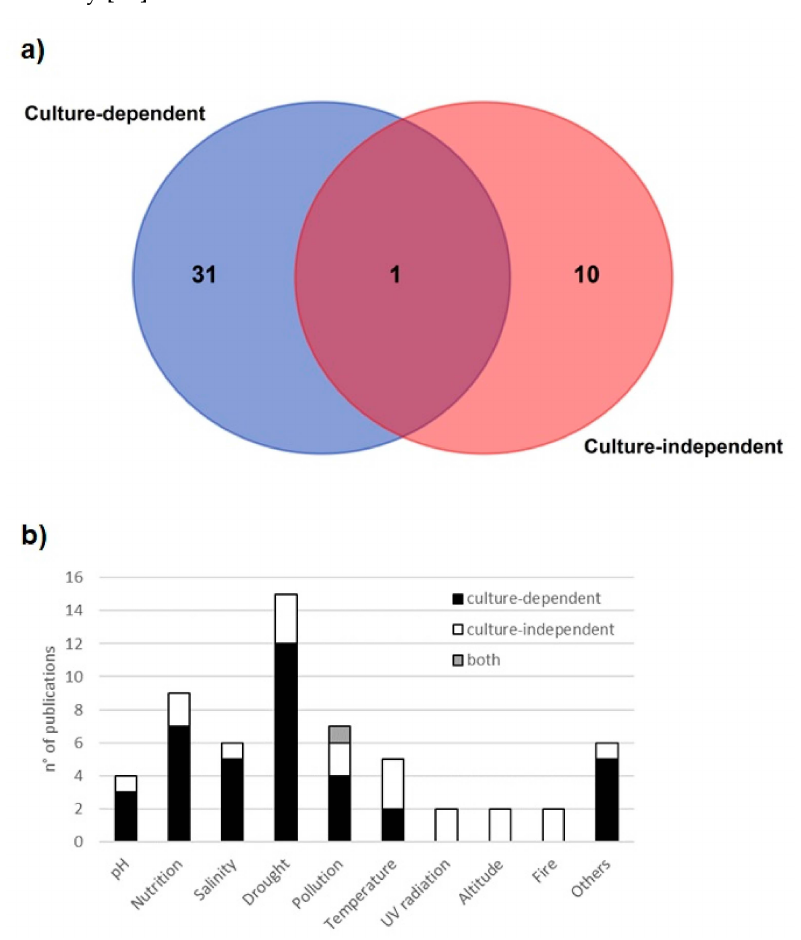
Figure 3. Publications with a research focus on PGPM + environmental stress + stress mitigation. ( a ) Venn diagram with the number of articles per study approach, ( b ) the number of articles per stress